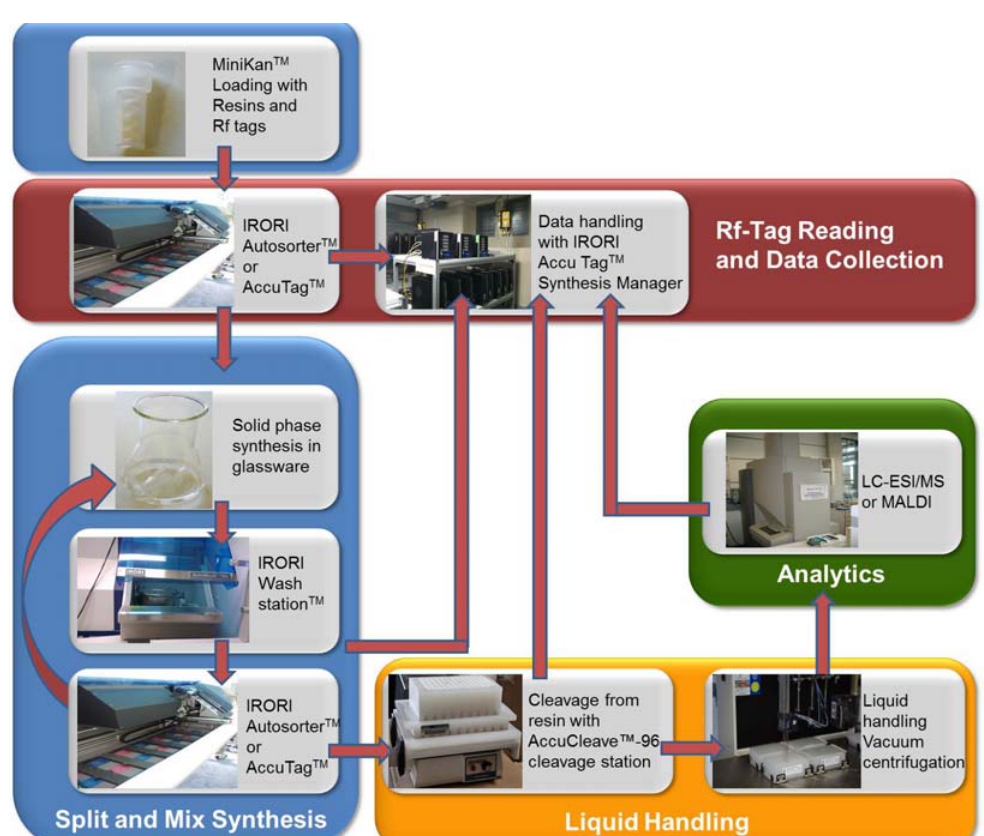
Figure 1. Schematic representation of the IRORI based solid phase chemistry of split and mix compound libraries. Depending on the size of the library the sorting can be performed manually by using the Accu TagTM Reader for up to 100 Kans or in an automated fashion by the Autosorter 10Kx (up to 10,000